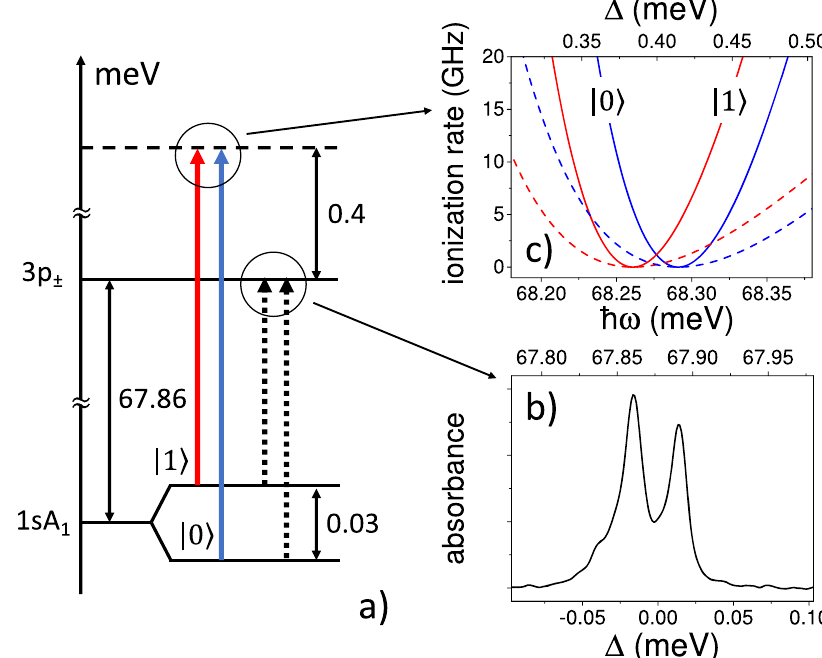
Fig. 4 An application of multi-photon induced continuum structure. a The level scheme of Si:Bi with a hyper fi ne split ground state and the 3p ± excited state. The MPICS ionization window is located at a detuning Δ = 0.4 meV above resonance. b Small-signal absorption spectrum against photon energy ħ ω of Si:Bi illustrating the well-resolved hyper fi ne splitting (data from ref. 50 ). c The MPICS windows for a fi eld amplitude in atomic units of F / F a = 0.15 (solid line) and 0.1 (dash line) illustrating the available state-selective ionization